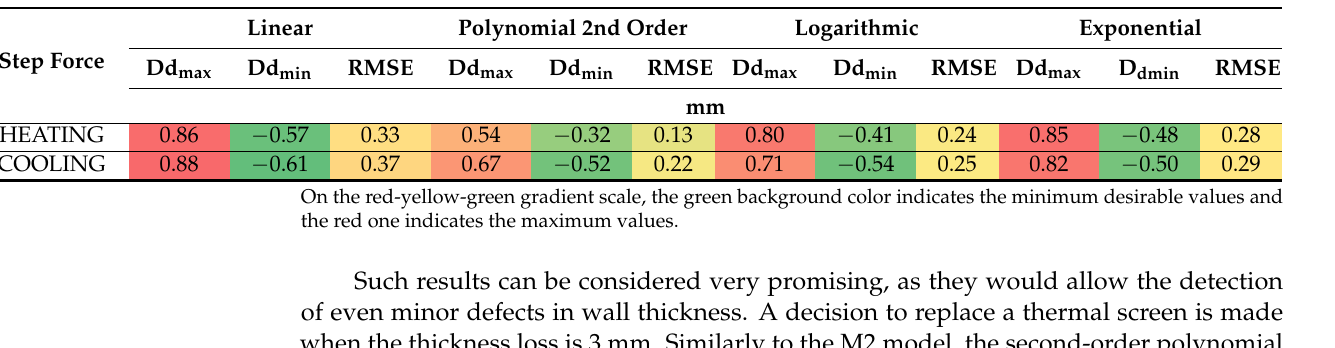
Table 4. Limiting errors of approximation, ˆ d and RMSE, for the estimation of the tube wall thickness for different types of excitations, using different M3